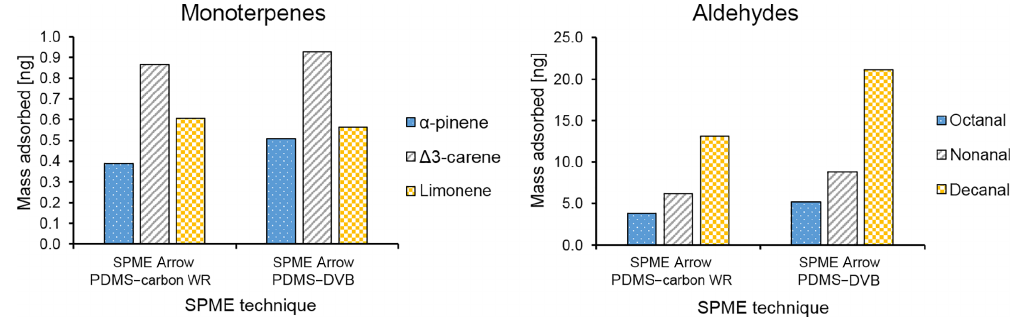
Figure 6. Comparison between the average mass of identified monoterpenes ( α -pinene, (cid:49) 3 -carene, and limonene) and aldehydes (octanal, nonanal, and decanal) collected with different SPME Arrow sorbents (PDMS–DVB and PDMS–carbon WR) from ambient air and measured by GC-MS.